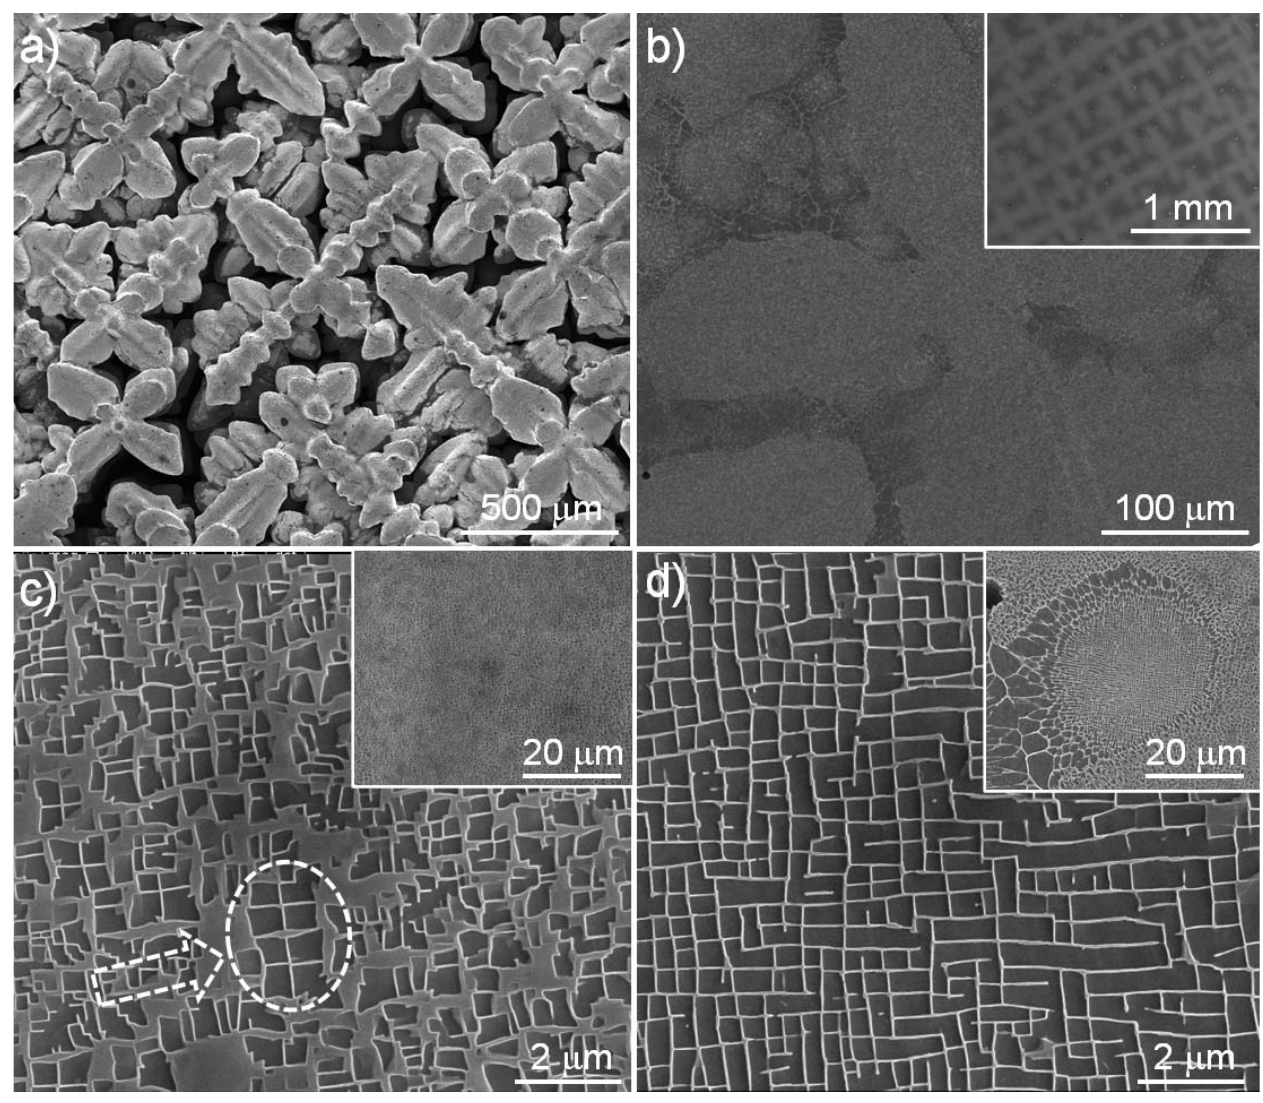
Figure 1. General images of a dendritic microstructure formed in a nickel-based single crystal superalloy: ( a ) as-cast dendrites found at the tip of a turbine blade at a low magnification image; ( b ) a dendrite after epoxy mounting, polishing, and etching with an insert showing a general morphology of dendrites; ( c ) a magnified image acquired at the dendrite core with an insert of a low magnification image; ( d ) a magnified image of an interdendritic region with a low magnification image. Note that in panels ( c , d ), the general and the magnified images were acquired at the same magnification.